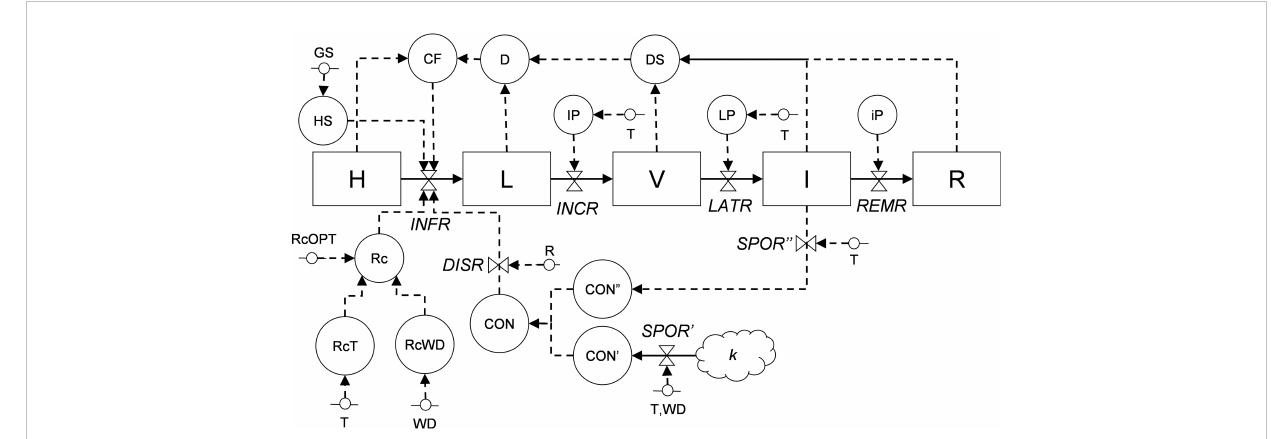
FIGURE 2 Relational diagram of the processes leading to infection by Colletotrichum spp. Acronyms for state variables, rates, and parameters are listed in Table 1. The core structure of the model is based on Zadoks (1971), with sites evolving from healthy (H), to latent (L), to visible (V), to infectious (I), and fi nally to removed